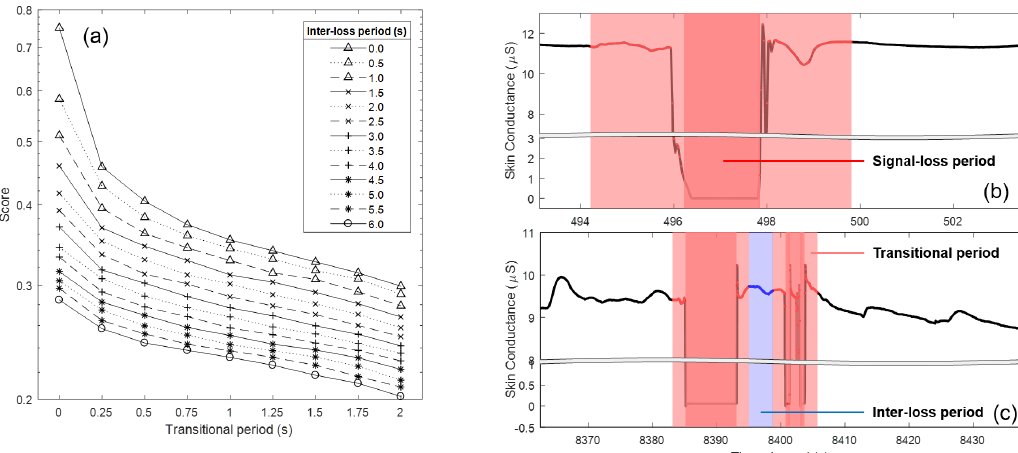
Figure 3. Results on the removal of transitional and inter-loss period. The effect of variations of the transitional and inter-loss period on the averaged normalized metrics is shown in ( a ). Examples of data portions that were marked as invalid periods are shown in ( b , c